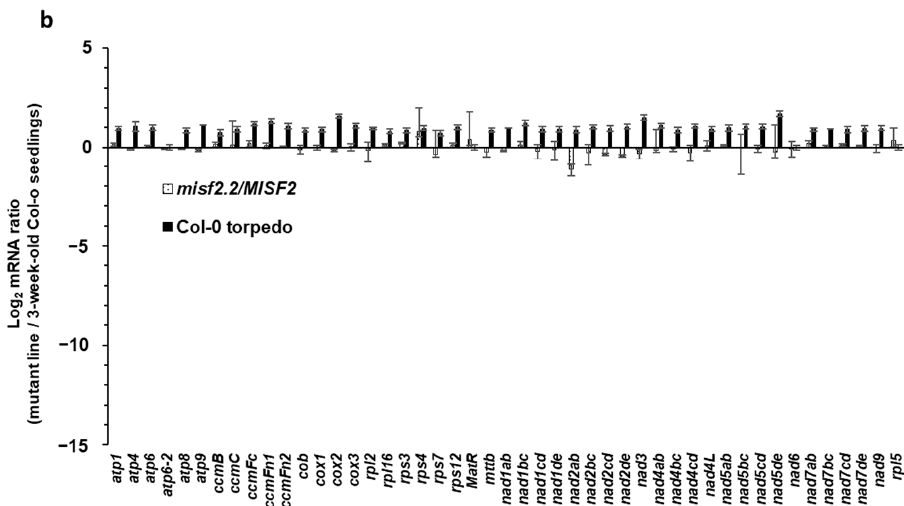
Figure 3. Relative accumulation of mitochondrial mRNAs in misf2 mutants. Analysis of various mt- RNAs levels in Arabidopsis wild-type (Col-0), misf2 mutants, and complemented misf2.2 / MISF2 plants by RT-qPCR. RNA extracted from 3-week-old wild-type seedlings (Col-0), 4-months-old rescued misf2 mutants, plantlets derived from immature Col-0 seeds (i.e., at the torpedo stage), and functionally complemented misf2.2 / MISF2 mutants were reverse-transcribed and the relative steady-state levels of cDNAs corresponding to mitochondrial mRNAs evaluated by qPCR. Log 2 ratios of mt mRNA abundances in misf2.1 and misf2.2 mutant lines ( a ), plantlets derived from immature Col-0 seeds, and complementation line ( b ) to those of 3-week-old MS-agar grown wild-type plants are shown. Asterisk indicates to reduced nad2ab transcript. The values are means of three biological replicates (error bars indicate one standard deviation).